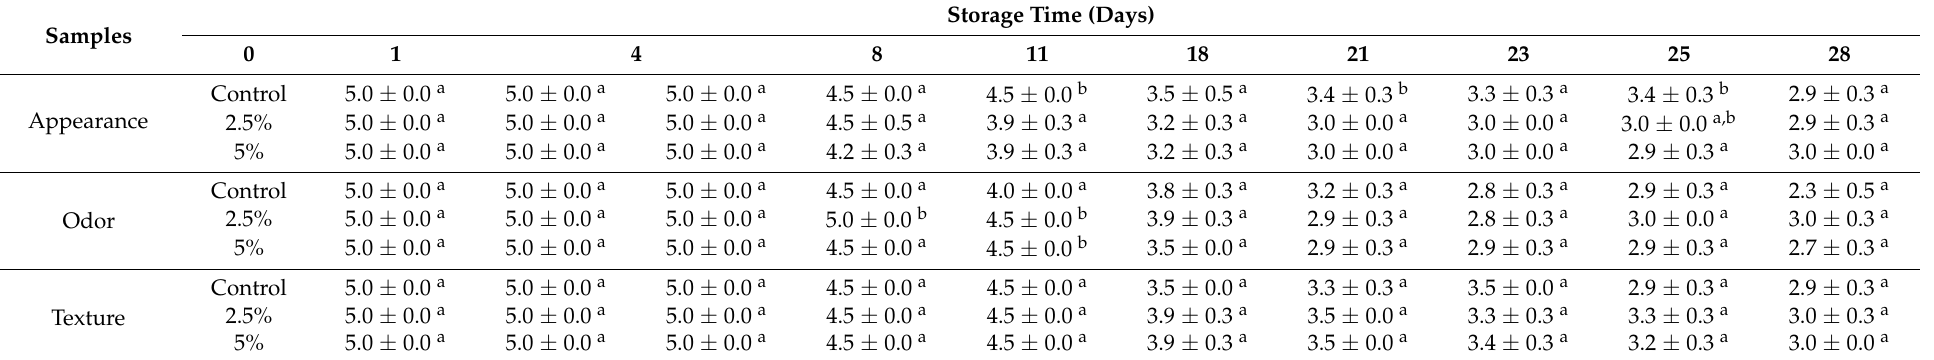
Table 1. Sensory attributes of active and non-active fresh fruit salad during 28 days of storage at 5 ◦